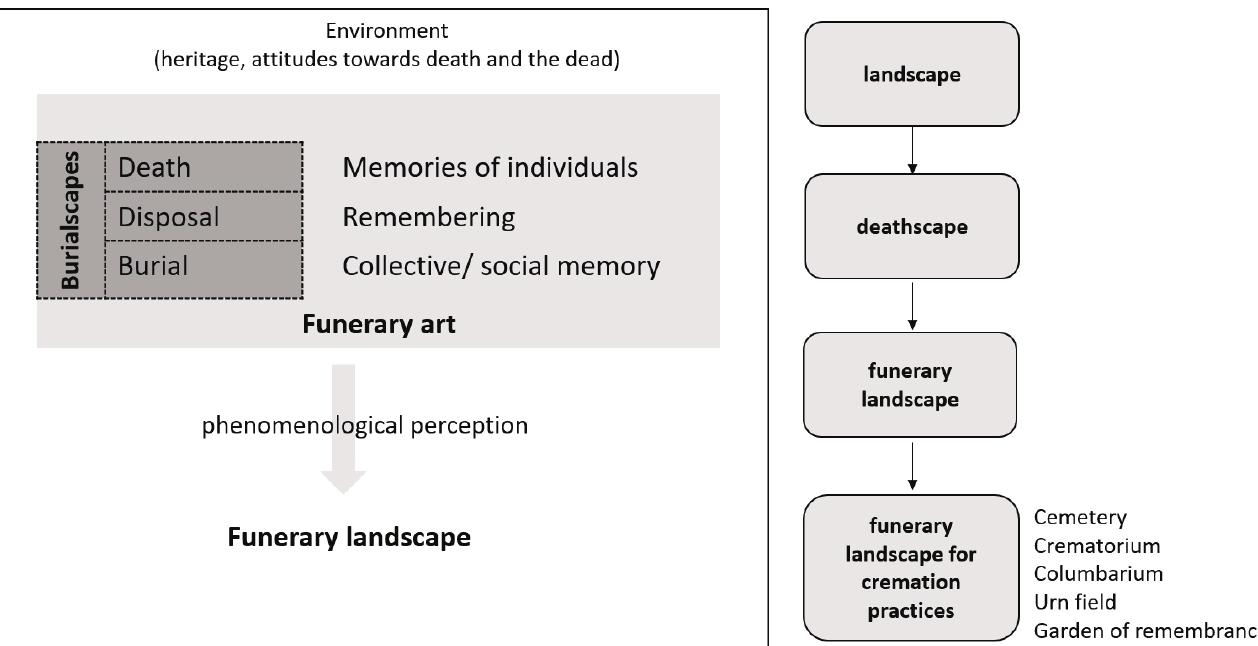
Figure 2. Funerary landscape for cremation practices as a specific type of cultural landscape. Own elaboration based on (Keddemann 2011, Daróczi